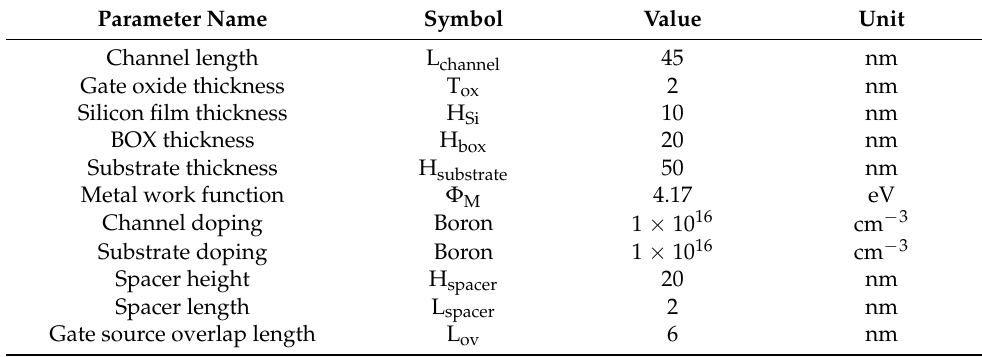
Table 1. Device parameters used for the